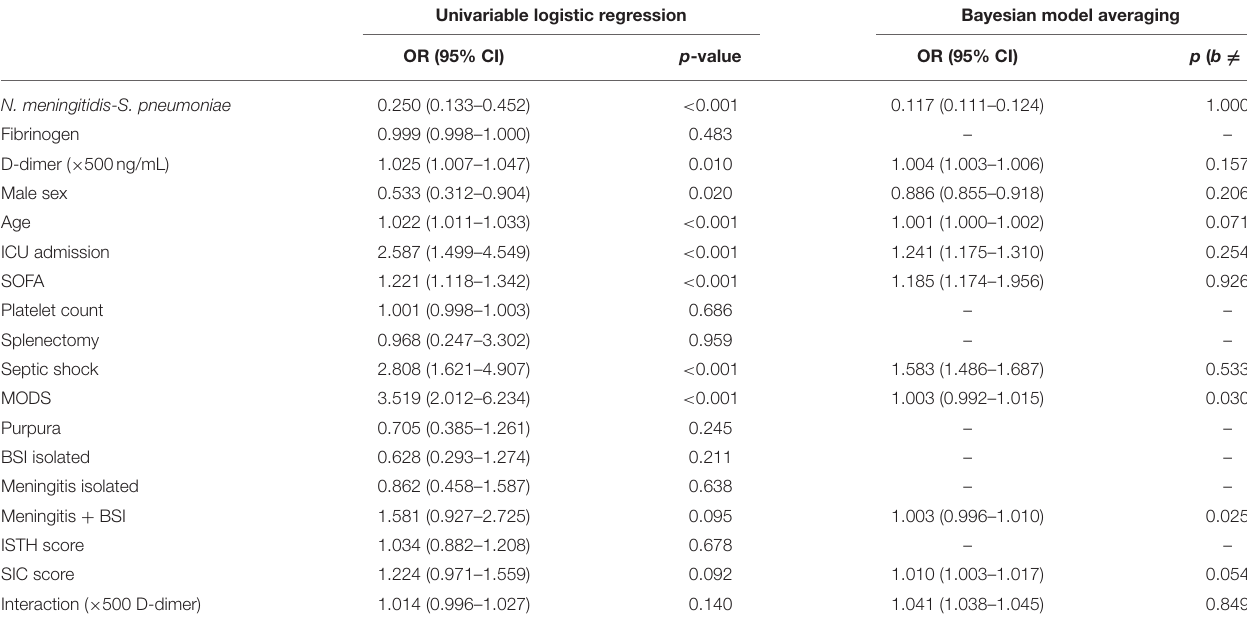
TABLE 2 | Univariable and multivariable logistic regression analysis (Bayesian model averaging).